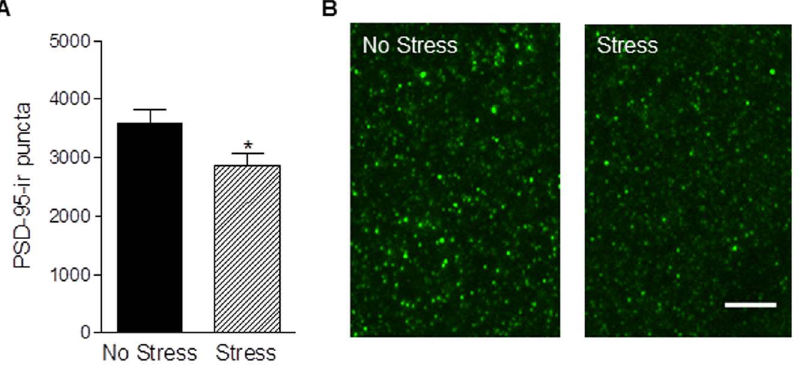
Figure 6. Chronic gestational reduces the number of PSD-95-ir puncta in the mPFC. Postpartum females stressed in pregnancy had fewer PSD-95-ir puncta in the mPFC (a). Representative confocal images of PSD-95-ir puncta in the mPFC, scale bar=5 m m (b). Bars represent mean 6 SEM, * p , 0.05.